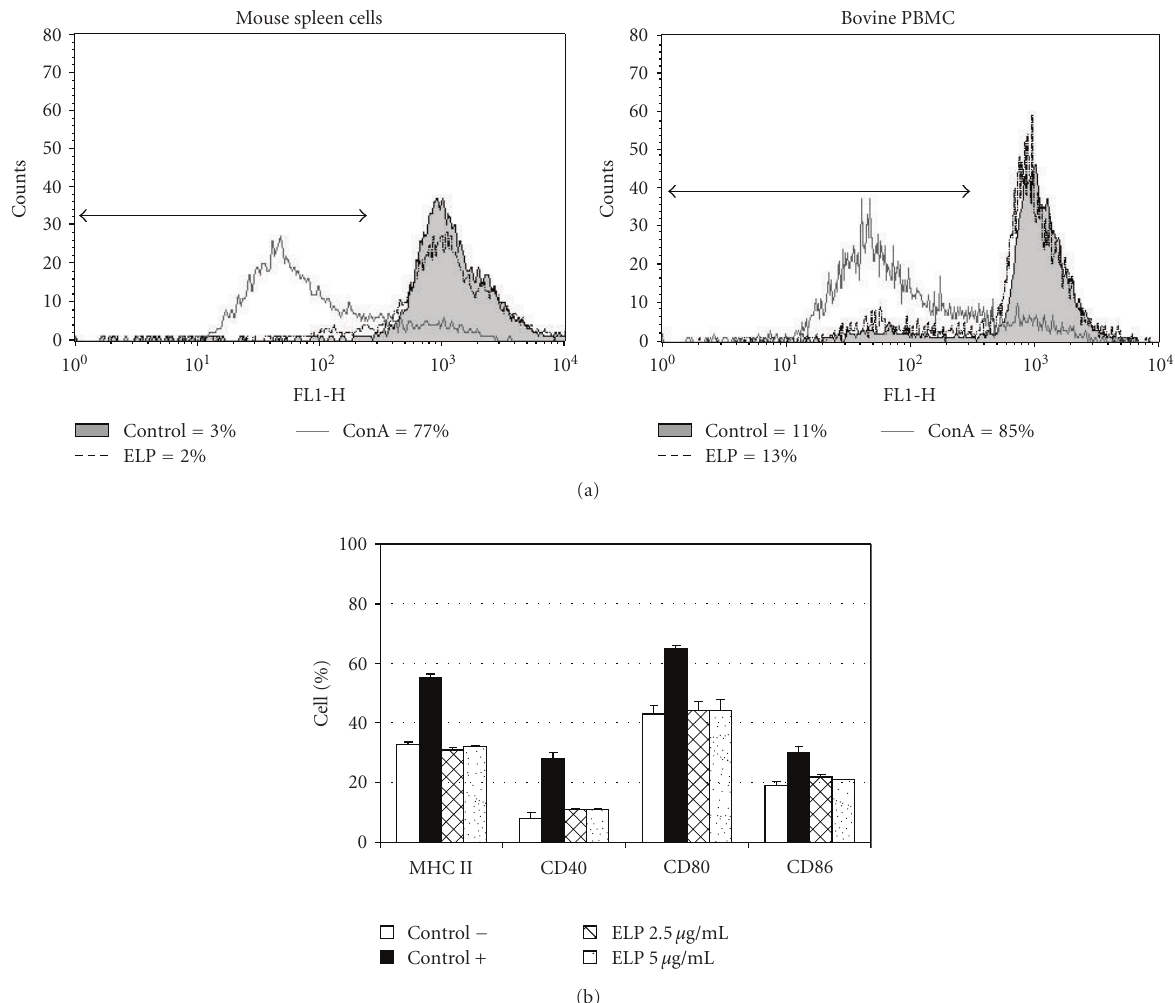
Figure 4: Impact of purified ELP on mouse and bovine immune cells. (a) ELP e ff ect on cell proliferation in mouse spleen cells and bovine PBMC. CFSE-stained mouse spleen cells and bovine PBMC were stimulated for 4 days with 5 μ g/mL of purified ELP (ELP) or mitogen ConA (ConA) or left untreated (Control). Cells were then collected and processed by flow cytometry for measurement of proliferating cells. The histograms show the FL1 emission values (FL1-H) for one representative experiment for each animal cell type out of two duplicate experiments. Results are expressed in percentage of cells that had undergone cell divisions, that is, with decreased CFSE fluorescence intensity. The control histogram (unstimulated cells) was filled in grey; the doted black line corresponded to ELP and the grey solid line to ConA stimulation. (b) ELP e ff ect on maturation marker expression in mouse bone marrow-derived dendritic cells (mBM-DCs). Mouse BM-DCs (10 6 cells/well) were stimulated for 24 hours with purified ELP (2.5 and 5 μ g/mL), LPS (control +) or left untreated (control − ). Cells were immunostained of the following cell surface markers: CMH II, CD40, CD80, CD86 and processed by flow cytometry as described in Material and Methods. The histogram presents the mean ( ± SD) of the percentages of fluorescing cells for each cell surface marker for two experiments done in